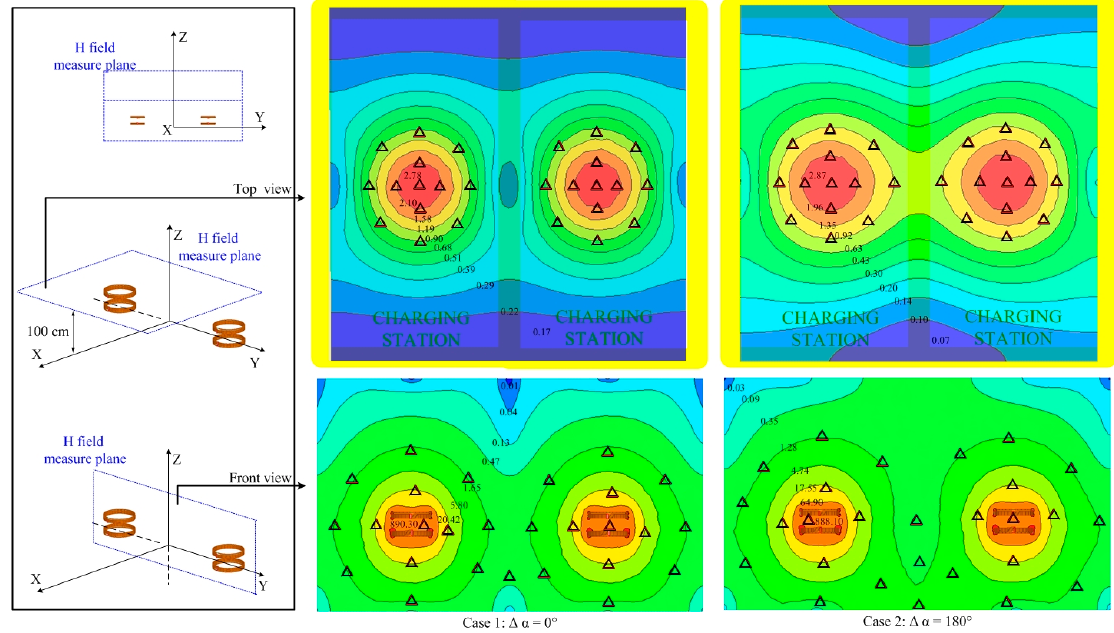
Figure 5. Magnetic field intensity (A/m) of two parallel WPT systems on the measure plane.